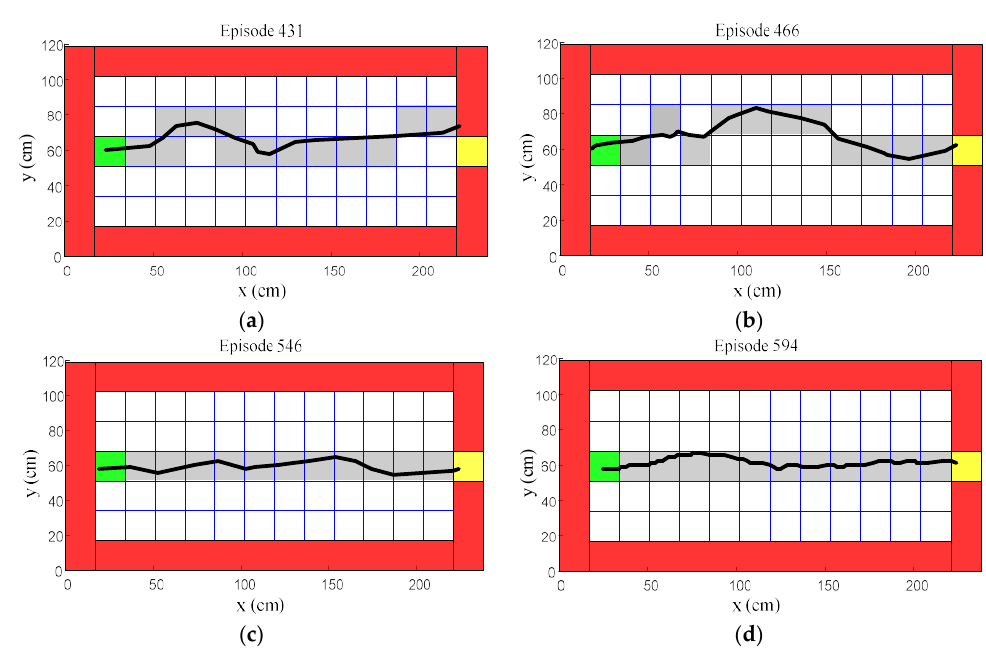
Figure 23. Results in the final stage of the learning process: ( a ) episode 431; ( b ) episode 466; ( c ) episode 546; ( d ) episode 594.